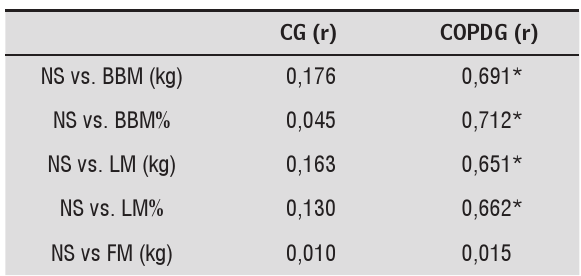
Table 3 - Correlation between 6MST’s NS and body